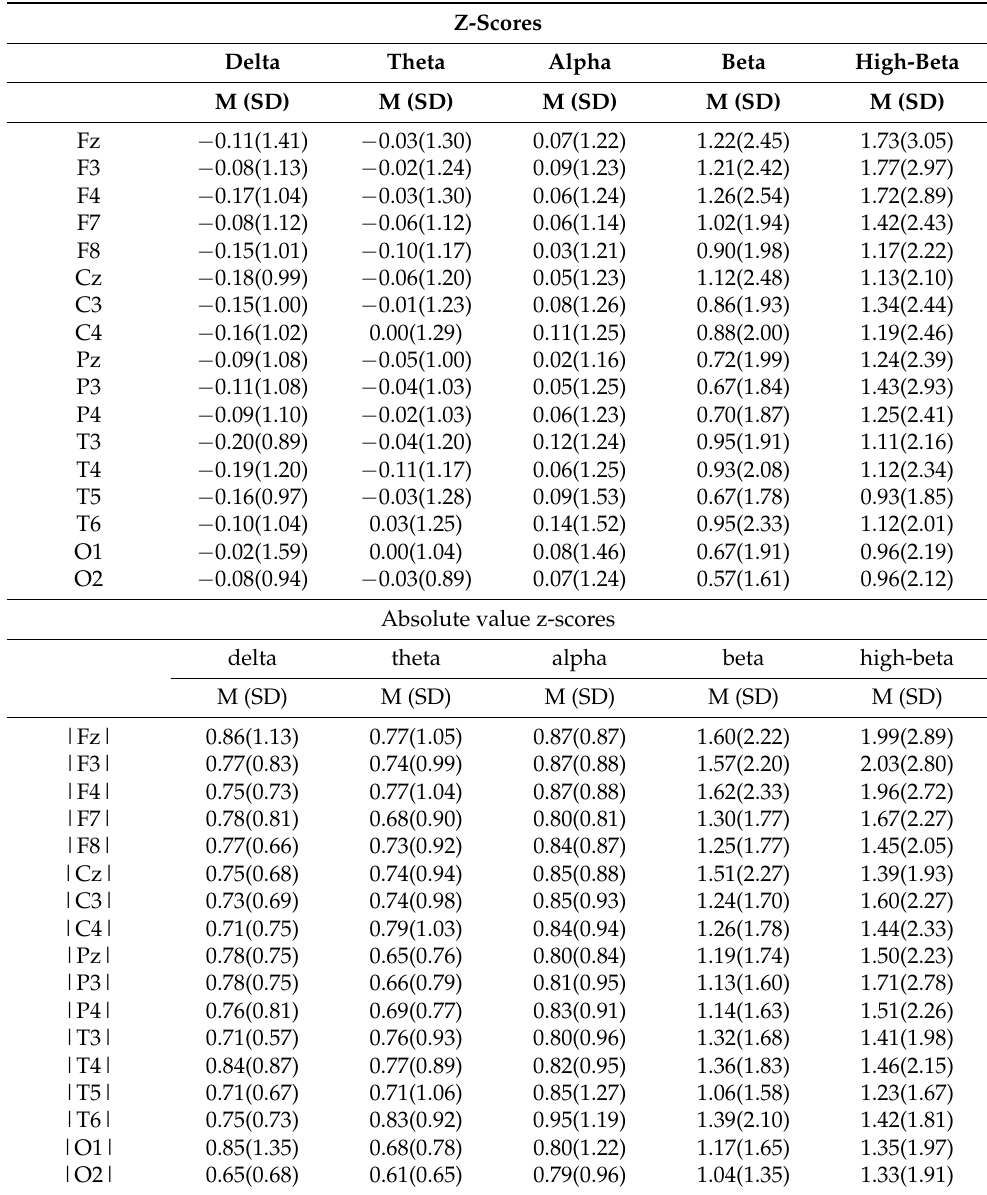
Table 4. The z-scores and absolute value z-scores in the MDD